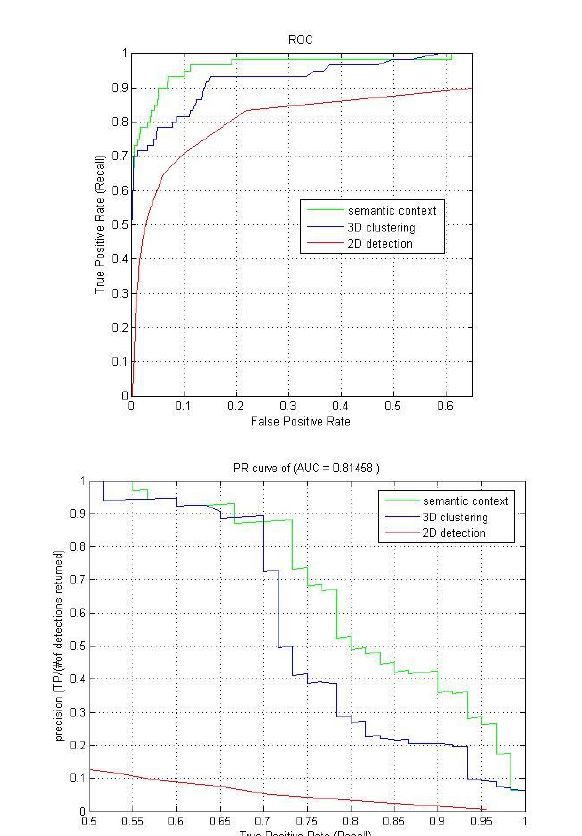
Figure 5: ROC and Precision Recall Curve. For Recall = 0.5 both 3D clustering and Semantic Context have perfect precision. For recall above 0.7 Semantic Context improves precision by a factor of